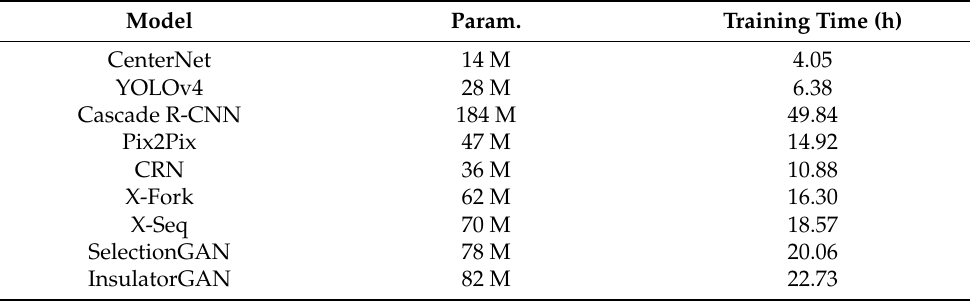
Table 12. Network parameters (Param.) and training time of the different